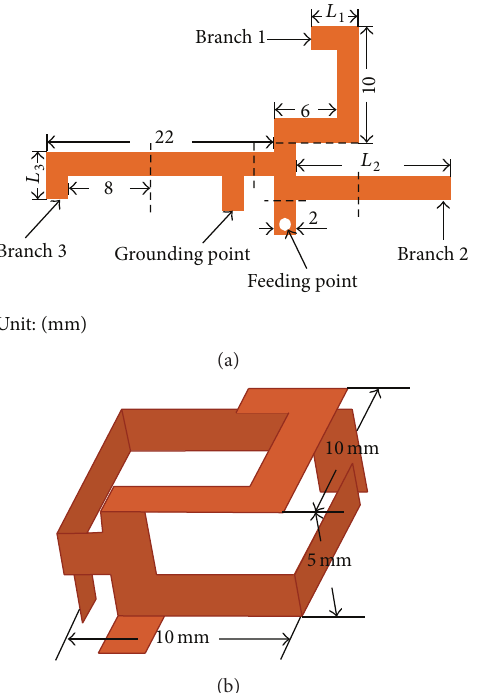
Figure 1: (a) Geometry of the antenna element; (b) 3D graph of the element.